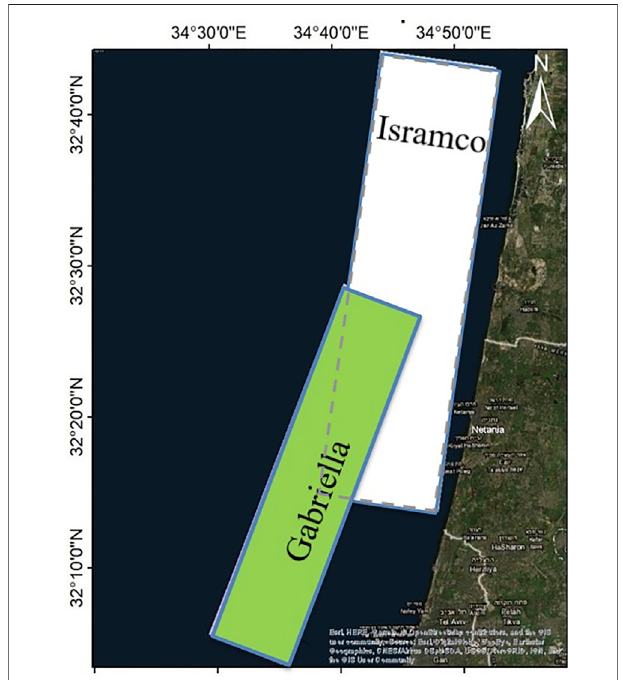
FIGURE 2 | Overlap between Isramco (white) and Gabriella (green) seismic volumes, and their location.